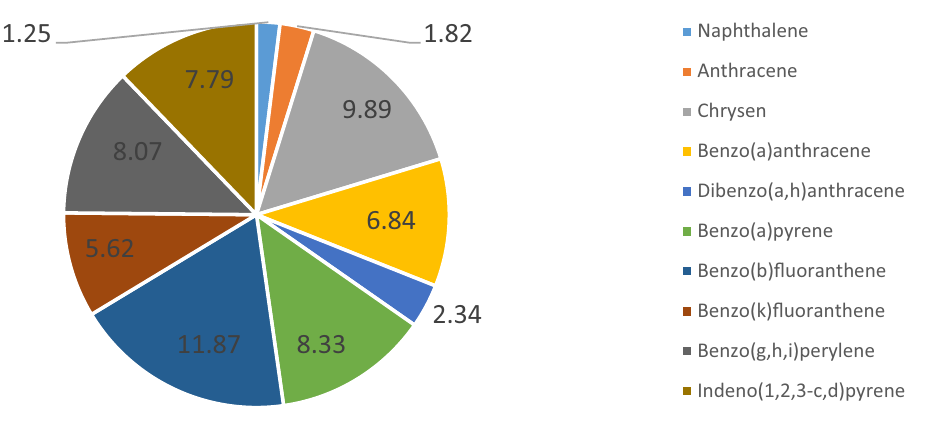
Figure 2. Share [%] of individual hydrocarbons in the total PAHs determined in soils from protected